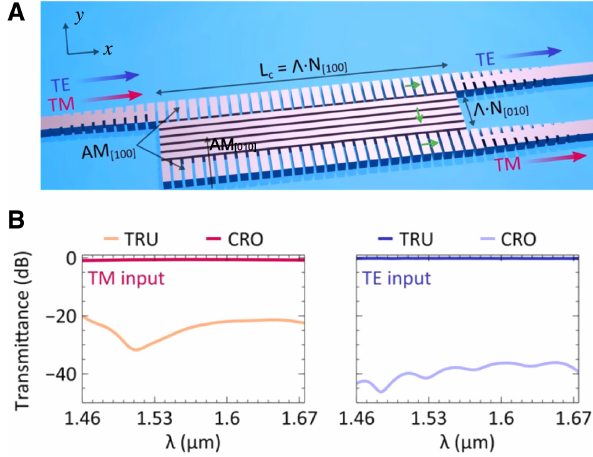
Figure 5: Ultrabroadband PBS using heteroanisotropic metamaterials. (A) Schematic diagram of the PBS. (B) Simulated transmission spectra of the through and cross ports for TM and TE mode inputs. Reprinted